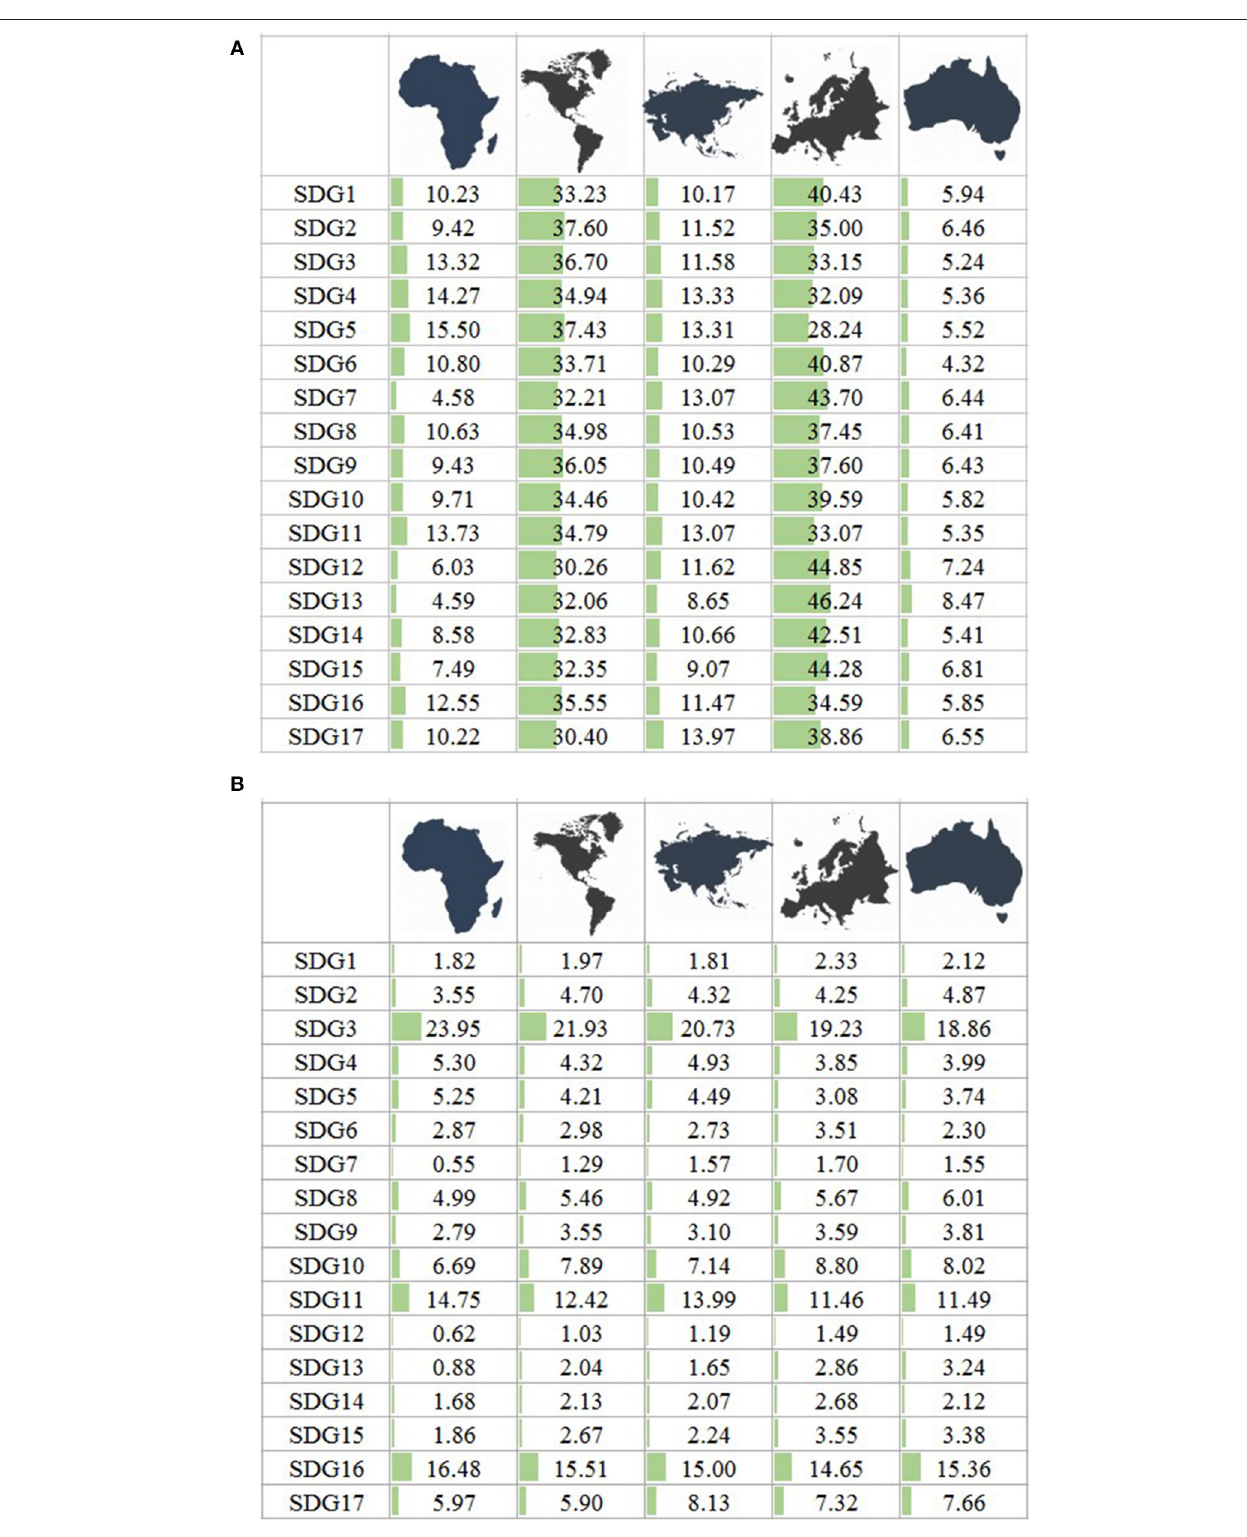
FIGURE 6 | Contribution of each continent to each SDGs (A) and profile by continent (B) .